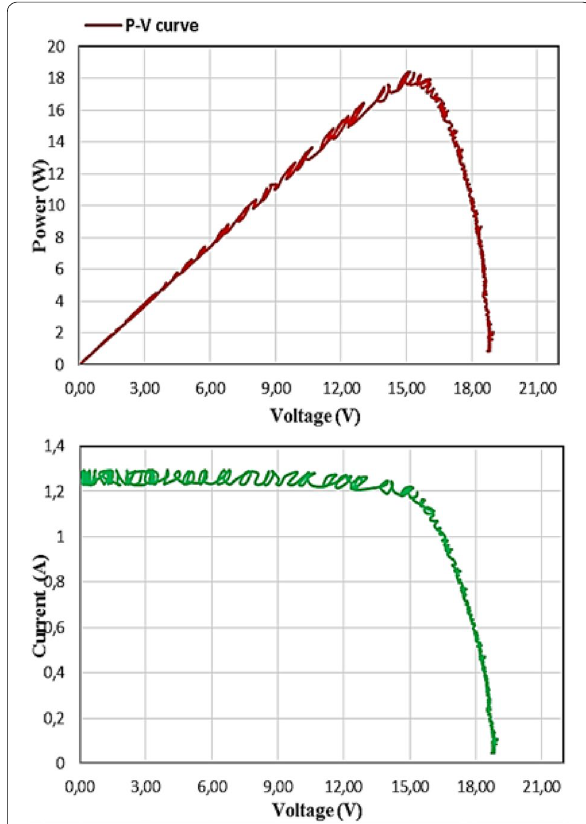
Fig. 19 I – V and P – V characteristics for PV panel by using with a sample time of 100 ms (at T